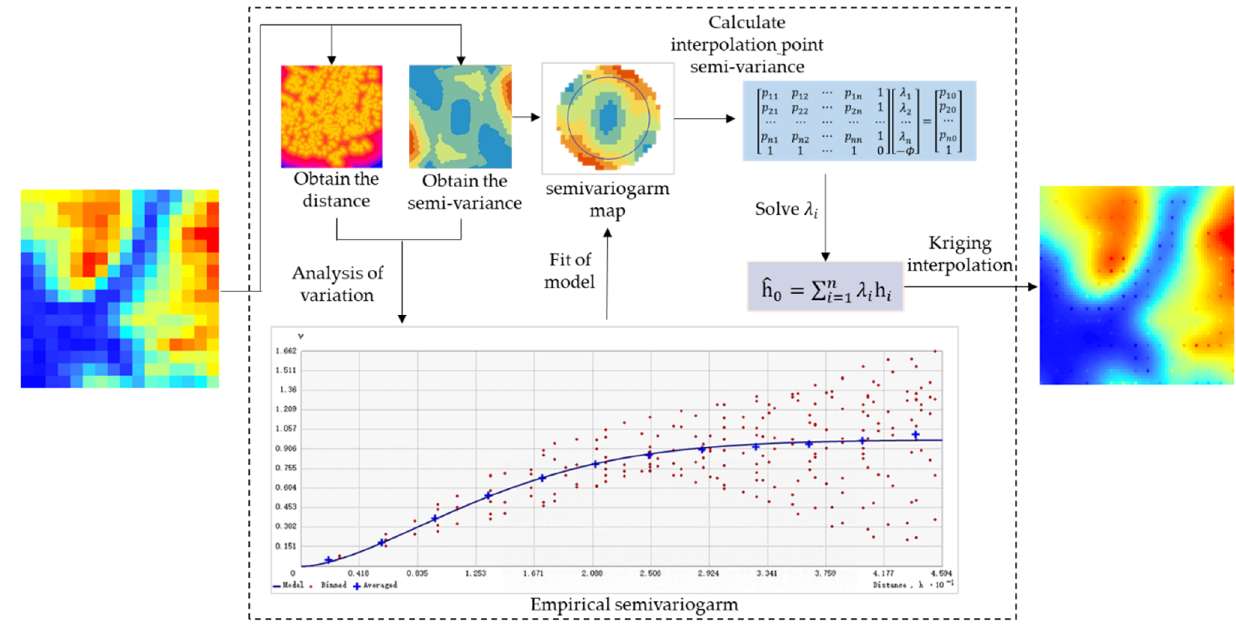
Figure 3. Process steps of Kriging interpolation (the left input is low-resolution DEM, and the right output is interpolated high-resolution DEM).